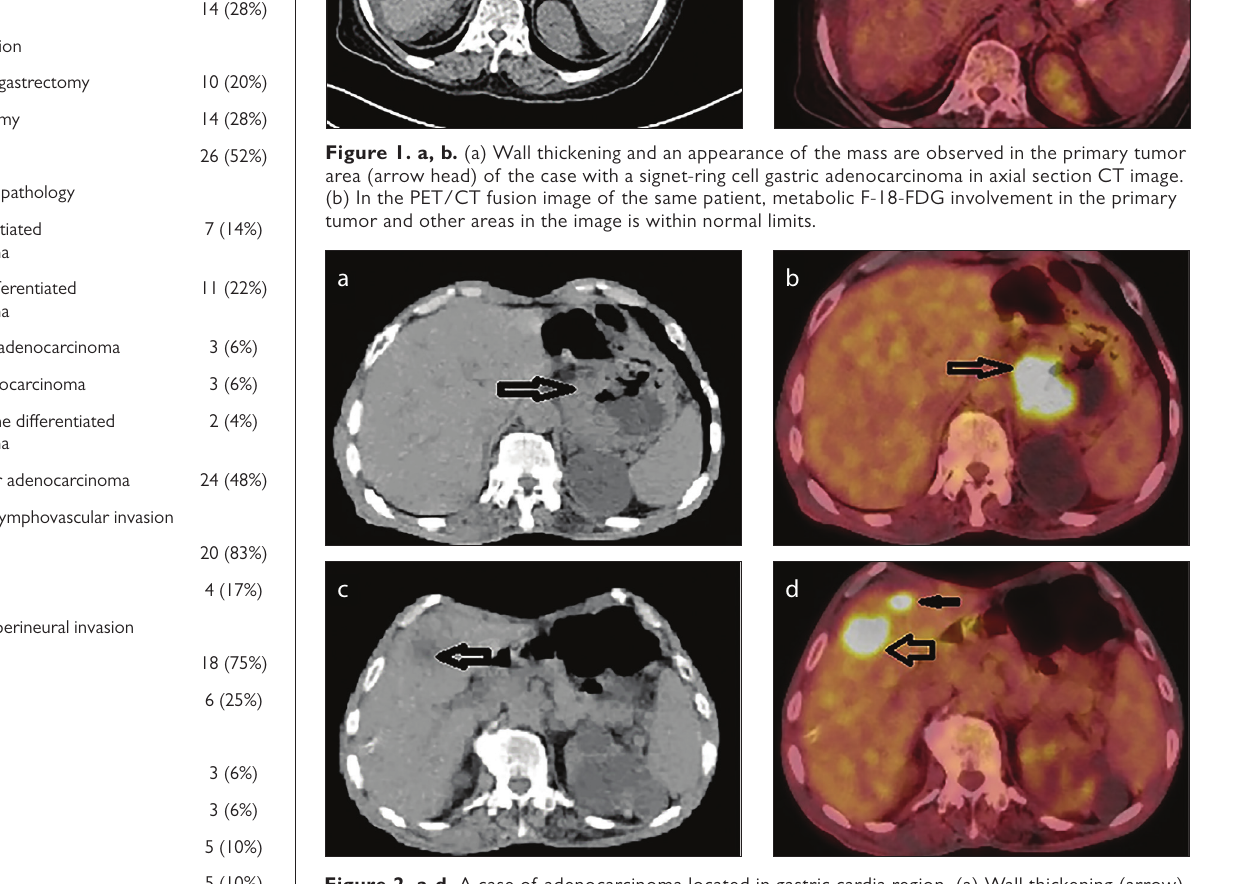
Table 1. Demographic, histopathological and clinical stage related features of patients Features